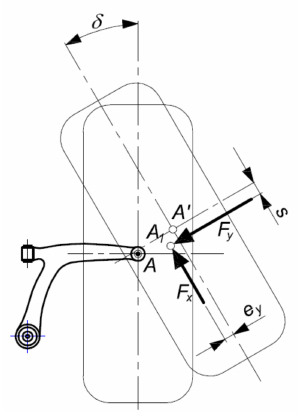
Figure 3. Forces acting on the rocker arm pin during the turning maneuver: F x —longitudinal force, F y —lateral force, e y —lateral displacement of the center of the tire footprint, s —displacement of the center of the tire footprint in the longitudinal direction, δ —the steering angle of the